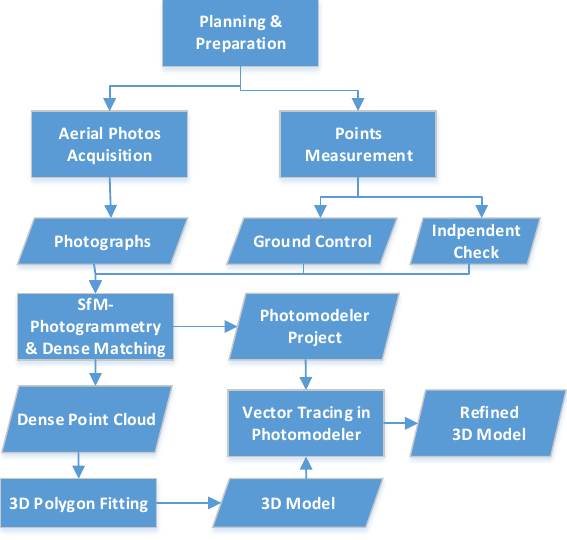
Figure 1. Overall schema of the proposed procedure